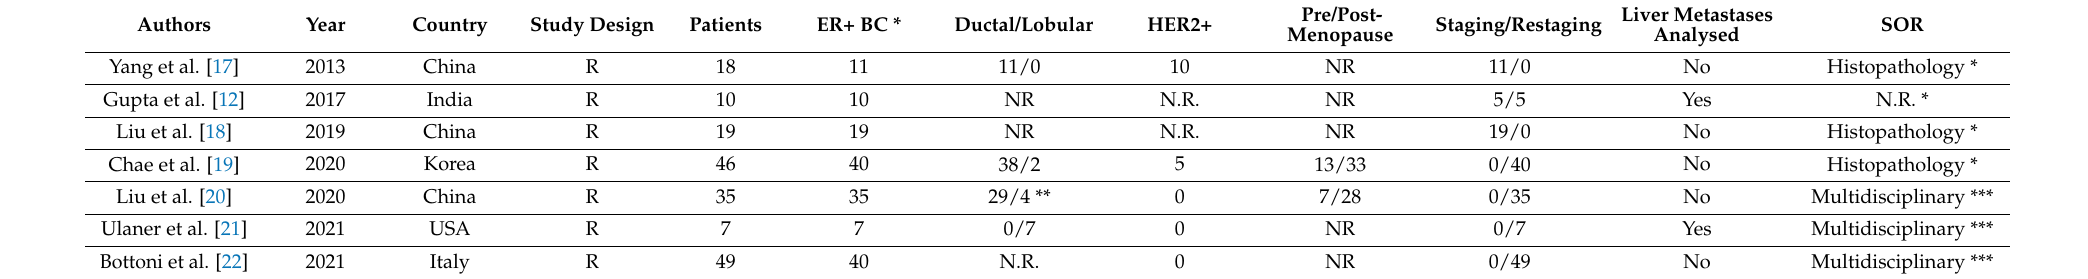
Table 1. Study and patient characteristics.